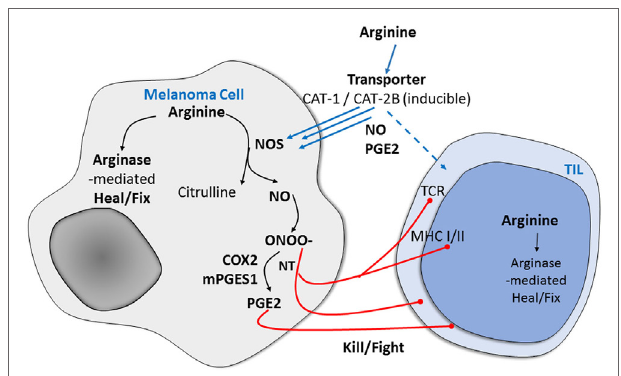
FigURe 1 | Potential mechanism of arginine metabolism in cancer cells versus immune-infiltrating cells in human melanoma. After arginine enters mammalian cells through the membrane-bound transporters CAT1 and CAT2B, it is metabolized by one of the NO synthase (NOS) enzymes to produce nitric oxide (NO), which is associated with immune suppression and results in the expression of specific markers and functional